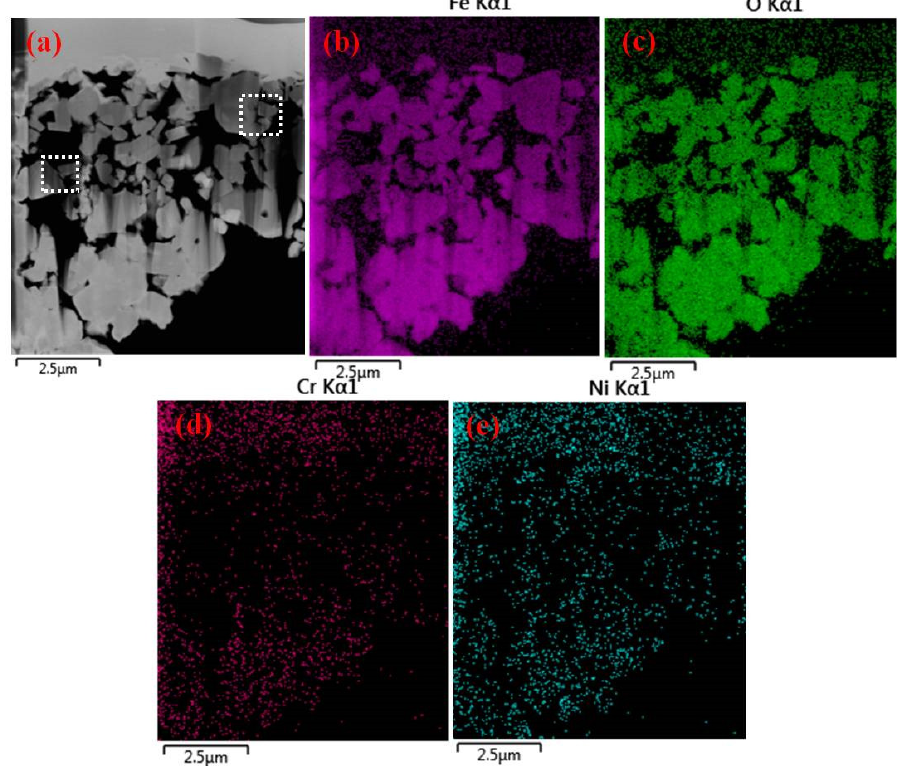
Figure 8. ( a ) TEM image of the cross-section of the micro-orifice after 500 h of immersion at 290 °C. ( b – e ) the mapping results of the cross-sectional elemental distribution of ( a ).